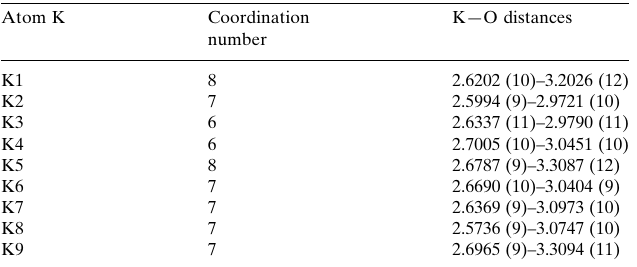
Characterization of K—O coordination spheres; coordination number as well as minimal and maximal distances (A˚ ) within the coordination spheres for each K atom are given.